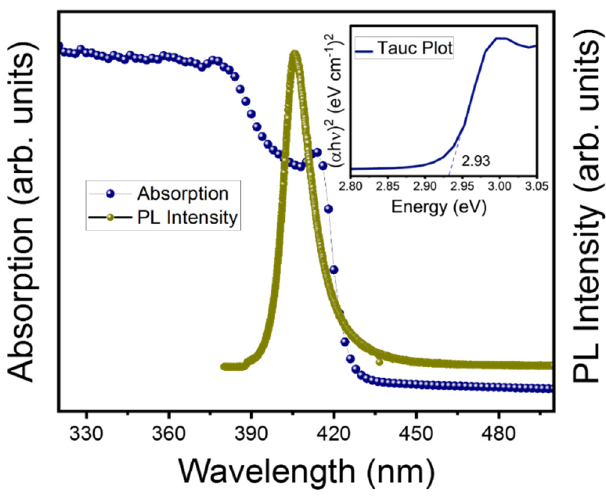
Figure 3. (Color online) Absorption and photoluminescence spectra of the MAPbCl 3 single crystal in the cubic phase 𝑃𝑚3𝑚 . Inset figure shows the calculated bandgap via the Tauc plot method.